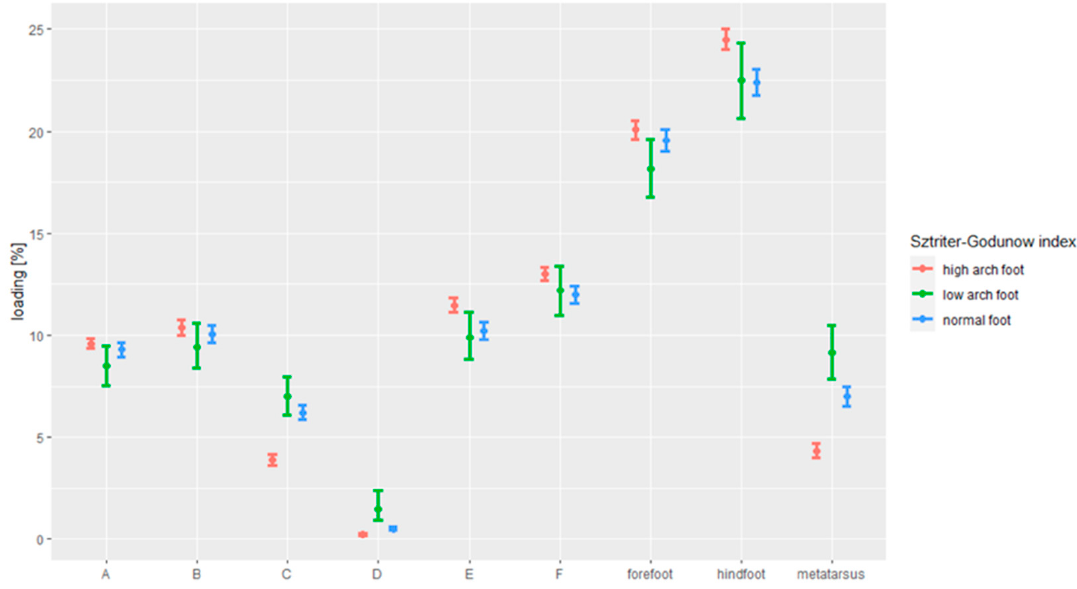
Figure 3. The dependence between foot loading under the static conditions and the Sztriter–Godunow index. Persons with elevated arches put more pressure on the forefoot (20.06%), as